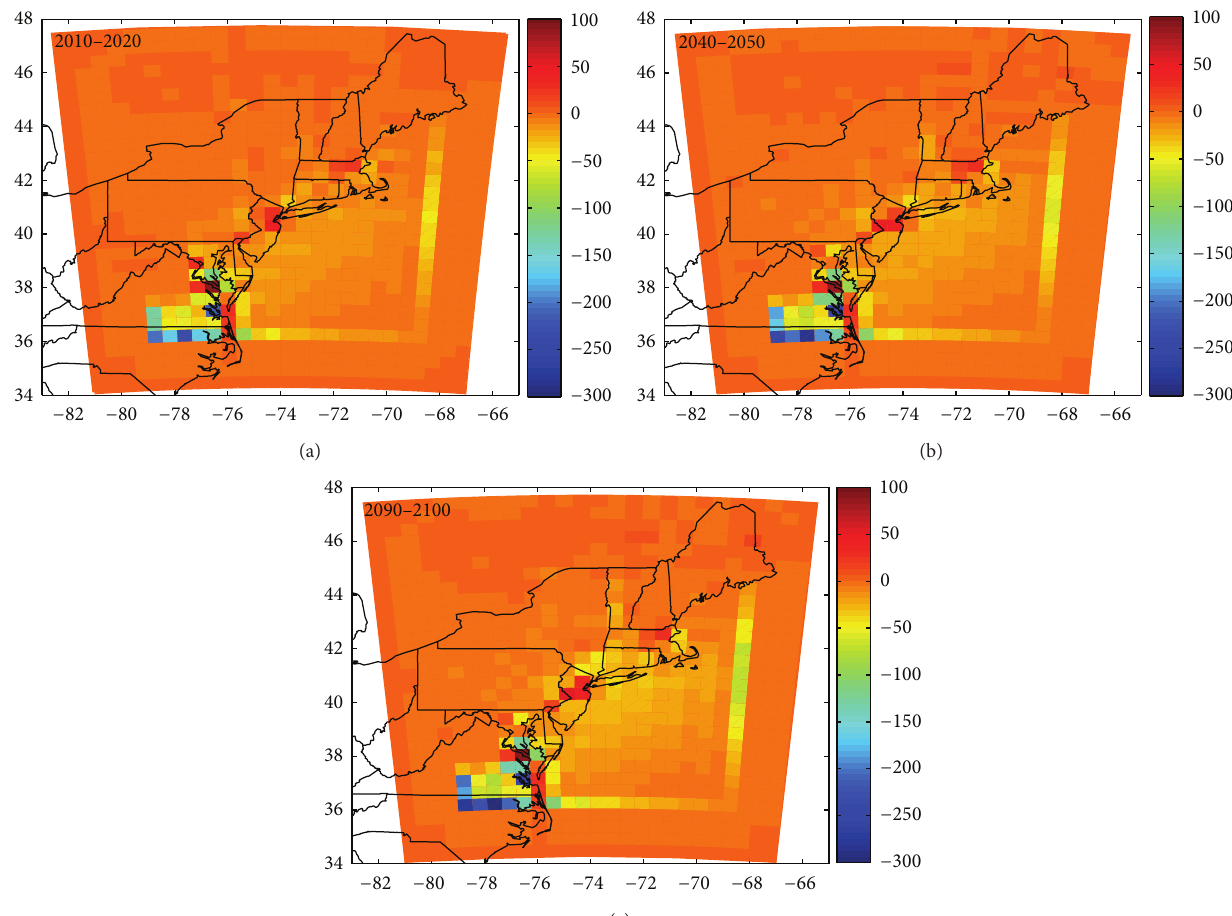
Figure 4: Effects of future urban expansion on average annual precipitation in the Northeast megalopolis, USA (unit: mm).